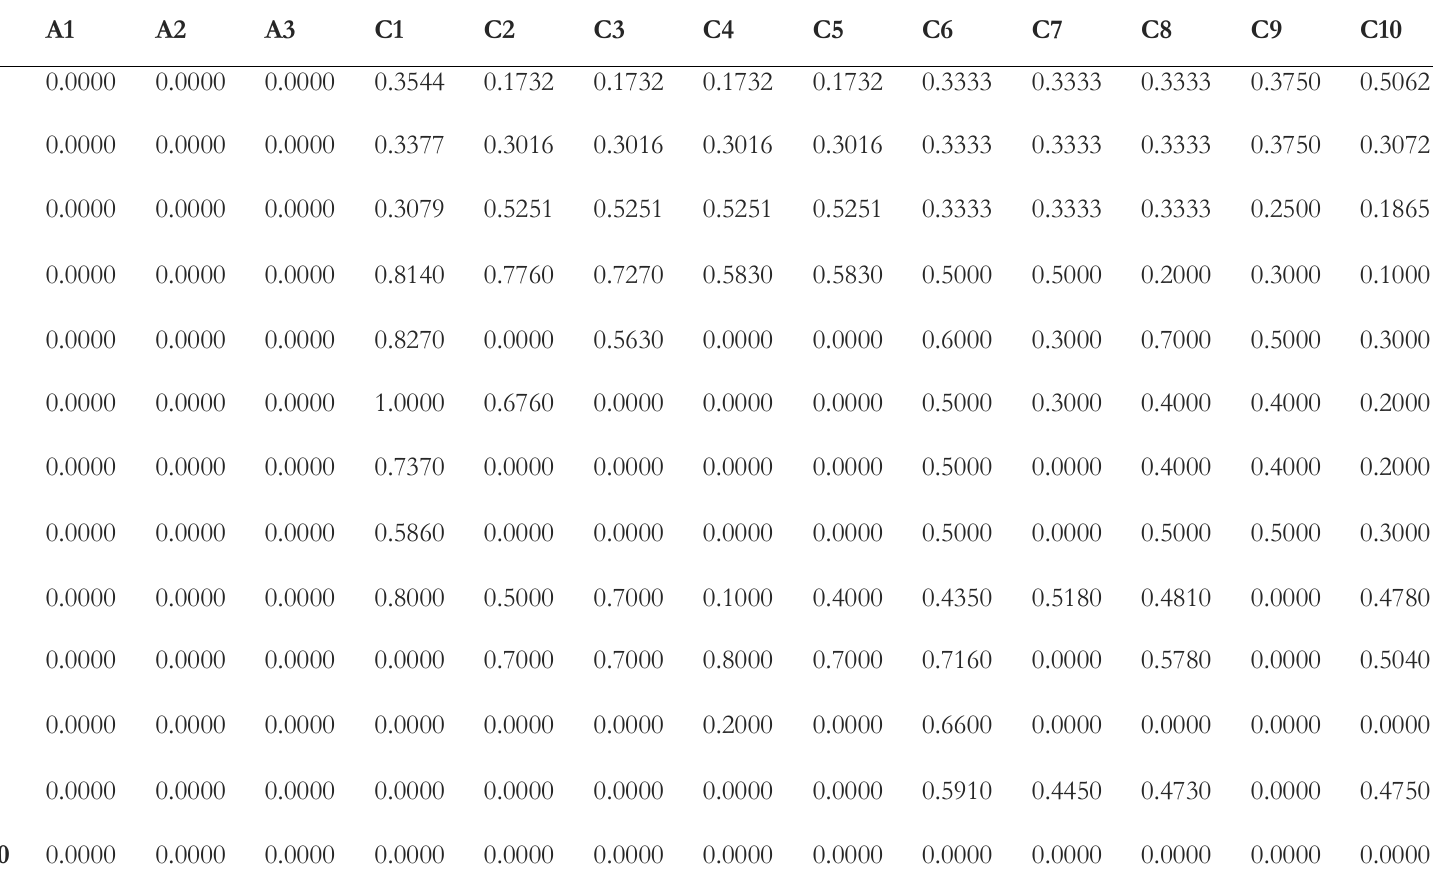
Table 10. Un-weighted supermatrix respecting the